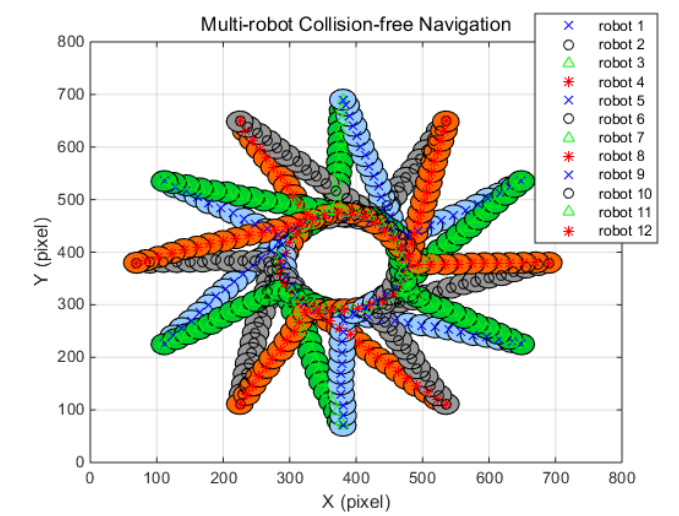
Figure 10. FAHP-CGT algorithm for 12 robot